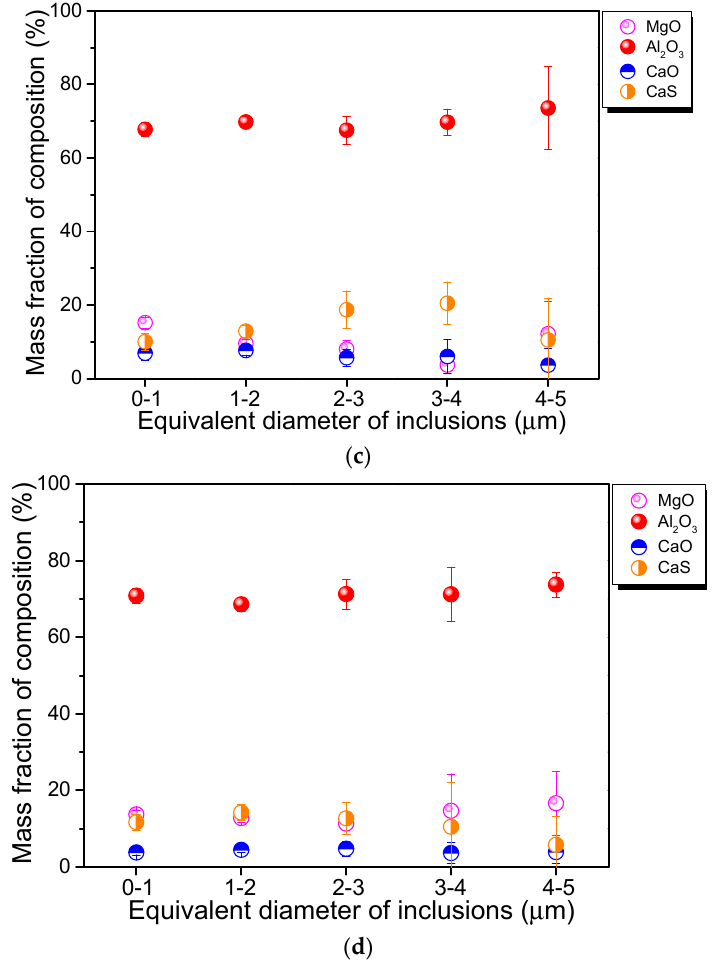
Figure 8. Evolution of the average mass fraction of each component in inclusions as a function of their diameter: ( a ) Before and after heat treatment at 1498 K for ( b ) 1 h, ( c ) 3 h, ( d ) 12 h. The variation in the number density and average diameter of the inclusions in the steel are shown in Figures 9 and 10, respectively. The number density of inclusions varied slightly with time when the steel was held at 1498 K. The average diameter of the inclusions in the steel decreased after heating, especially after 12 h heat treatment at 1498 K.